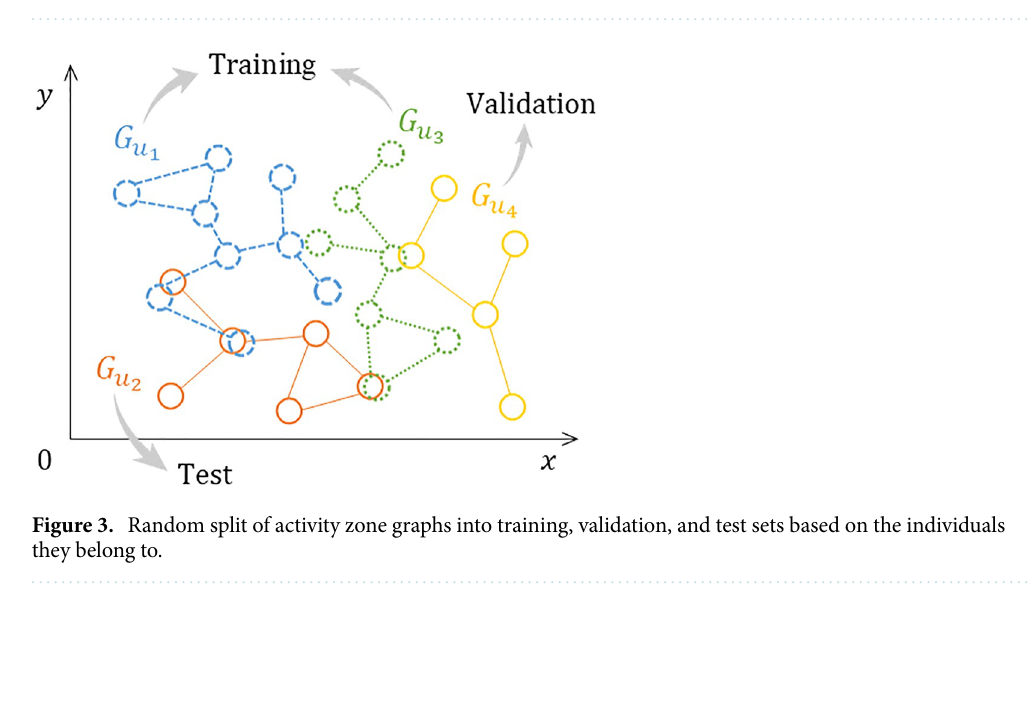
Figure 2. Architecture of aggregators and supervised learning.